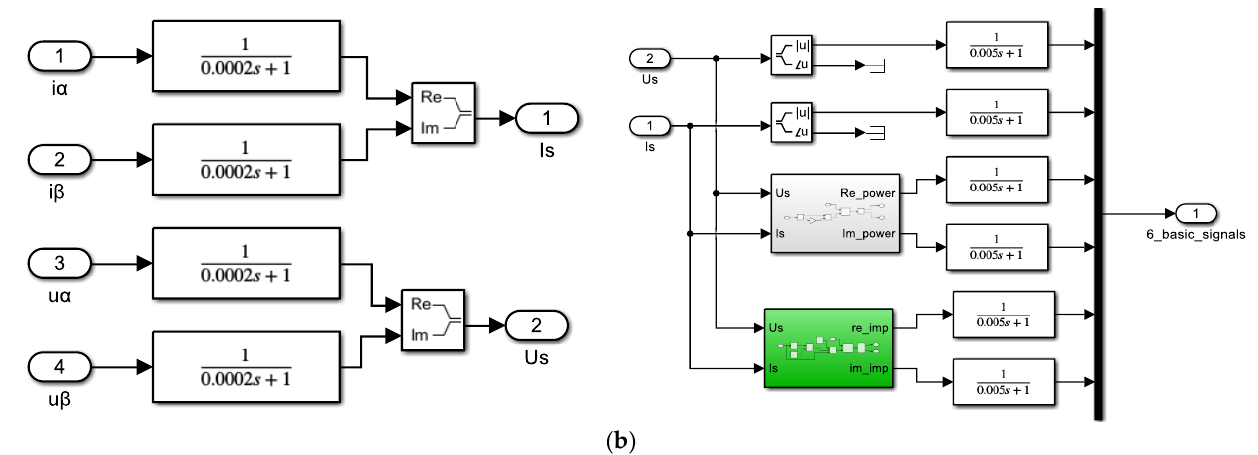
Figure 4. ( a ) Feed-forward neural network of speed estimator; ( b ) detailed implementation of ANN speed estimator.